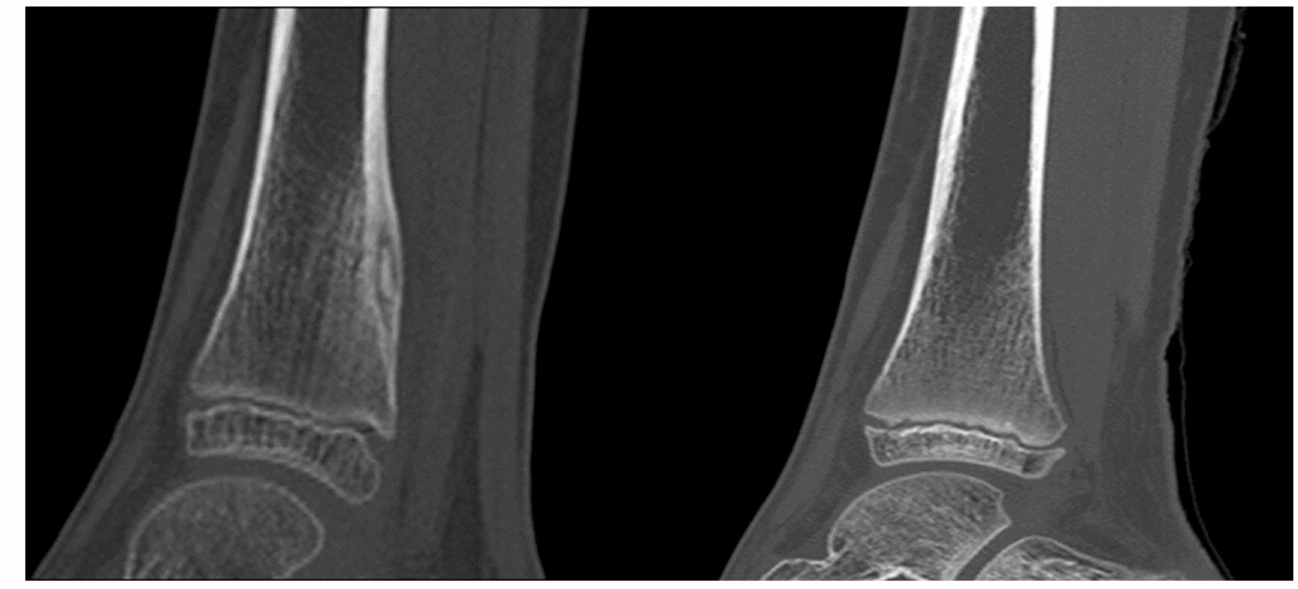
Figure 5. An OO of the distal diaphysis in an 8-years old girl treated successfully with MRgFUS. A complete restitution ad integrum was observed (follow-up time: 24 months).